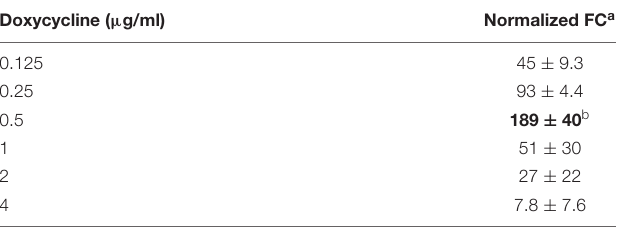
TABLE 6 | Molecular MIC analysis of Y. pestis EV76 isolated from blood cultures.